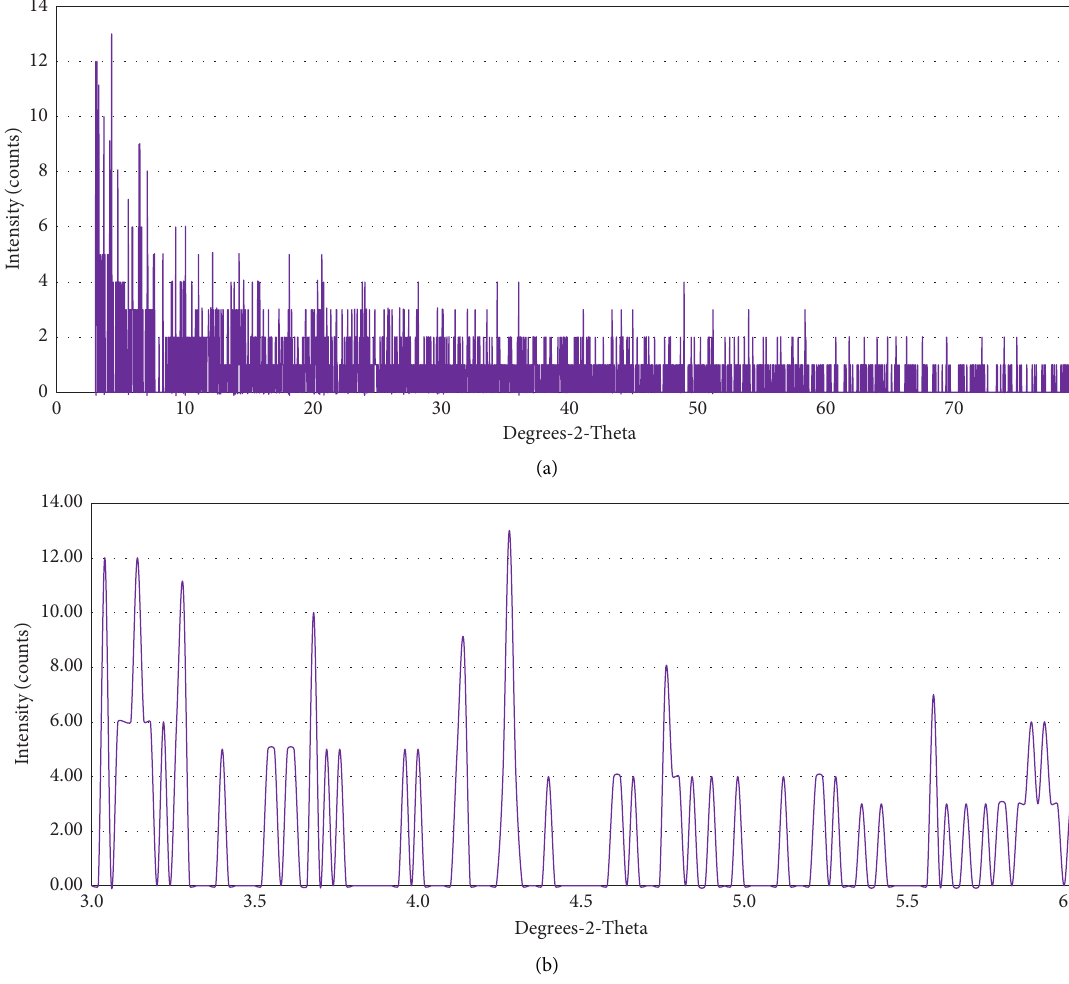
Figure 14: XRD micrographs for plain concrete. (a) Characteristic patterns in the 2 θ range between 3 ° and 80 ° . (b) Higher characteristic peaks in the 2 θ range between 3 ° and 6 ° .